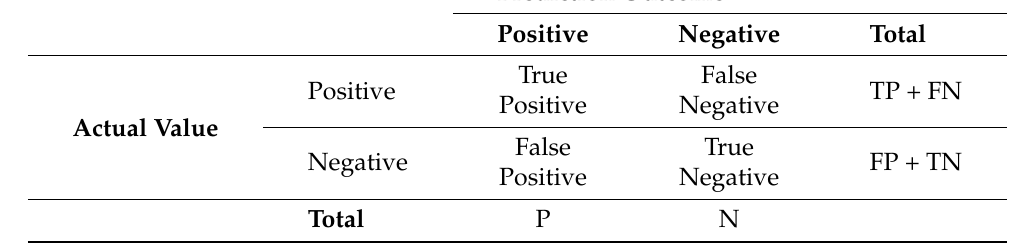
Table 1. Confusion